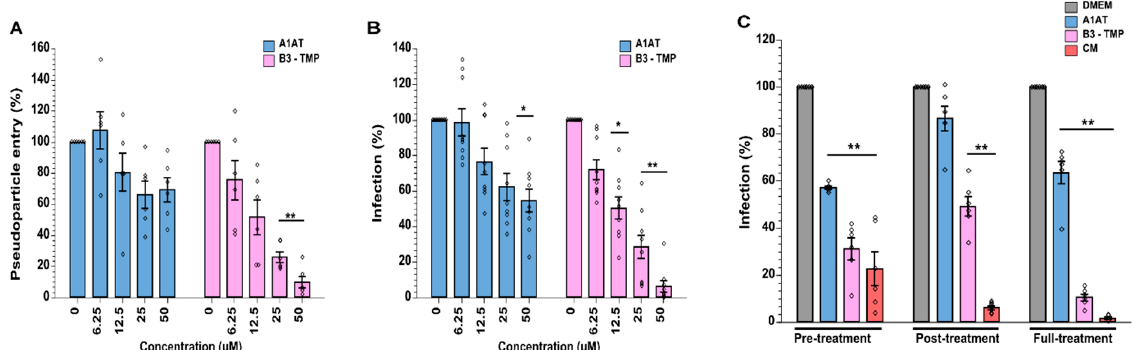
Figure 6. SerpinB3 anti-TMPRSS2 variant is more effective than A1AT at suppressing SARS-CoV-2 infection. ( A ) A1AT and B3-TMP were added to A549-ACE2-TMPRSS2 cells 1 h prior to infection with pseudoparticles and along with the pseudoparticles. ( B ) B3-TMP was compared with A1AT in VeroE6/TMPRSS2 cells. Cells were treated with serpin variants 1 h before, simultaneously with, and overnight after infection with SARS-CoV-2. ( C ) B3-TMP, A1AT, and CM were added as ‘Pre- treatment’ (1 h before infection and maintained for 1 h infection), ‘Post-treatment’ (added after the infection, when the virus had been removed) and ‘Full-treatment’ (both pre-treatment and then post- treatment with fresh drug) in VeroE6/TMPRSS2 cells. The mean ± SEM from n = 2 ( A , C ) or n = 3 ( B ) independent experiments performed in triplicates. Two-way ANOVA with Tukey’s comparison test: * p < 0.05, ** p <